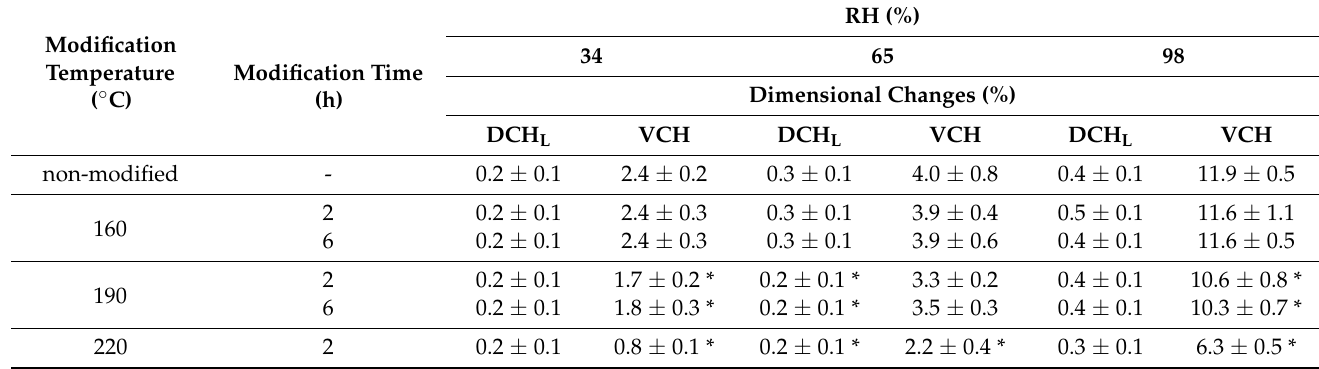
Table 6. Dimensional changes in longitudinal direction (DCH L ) and volumetric changes (VCH) of black poplar, non- modified and thermally modified in nitrogen atmosphere, during humidification at different relative humidity (RH); ±